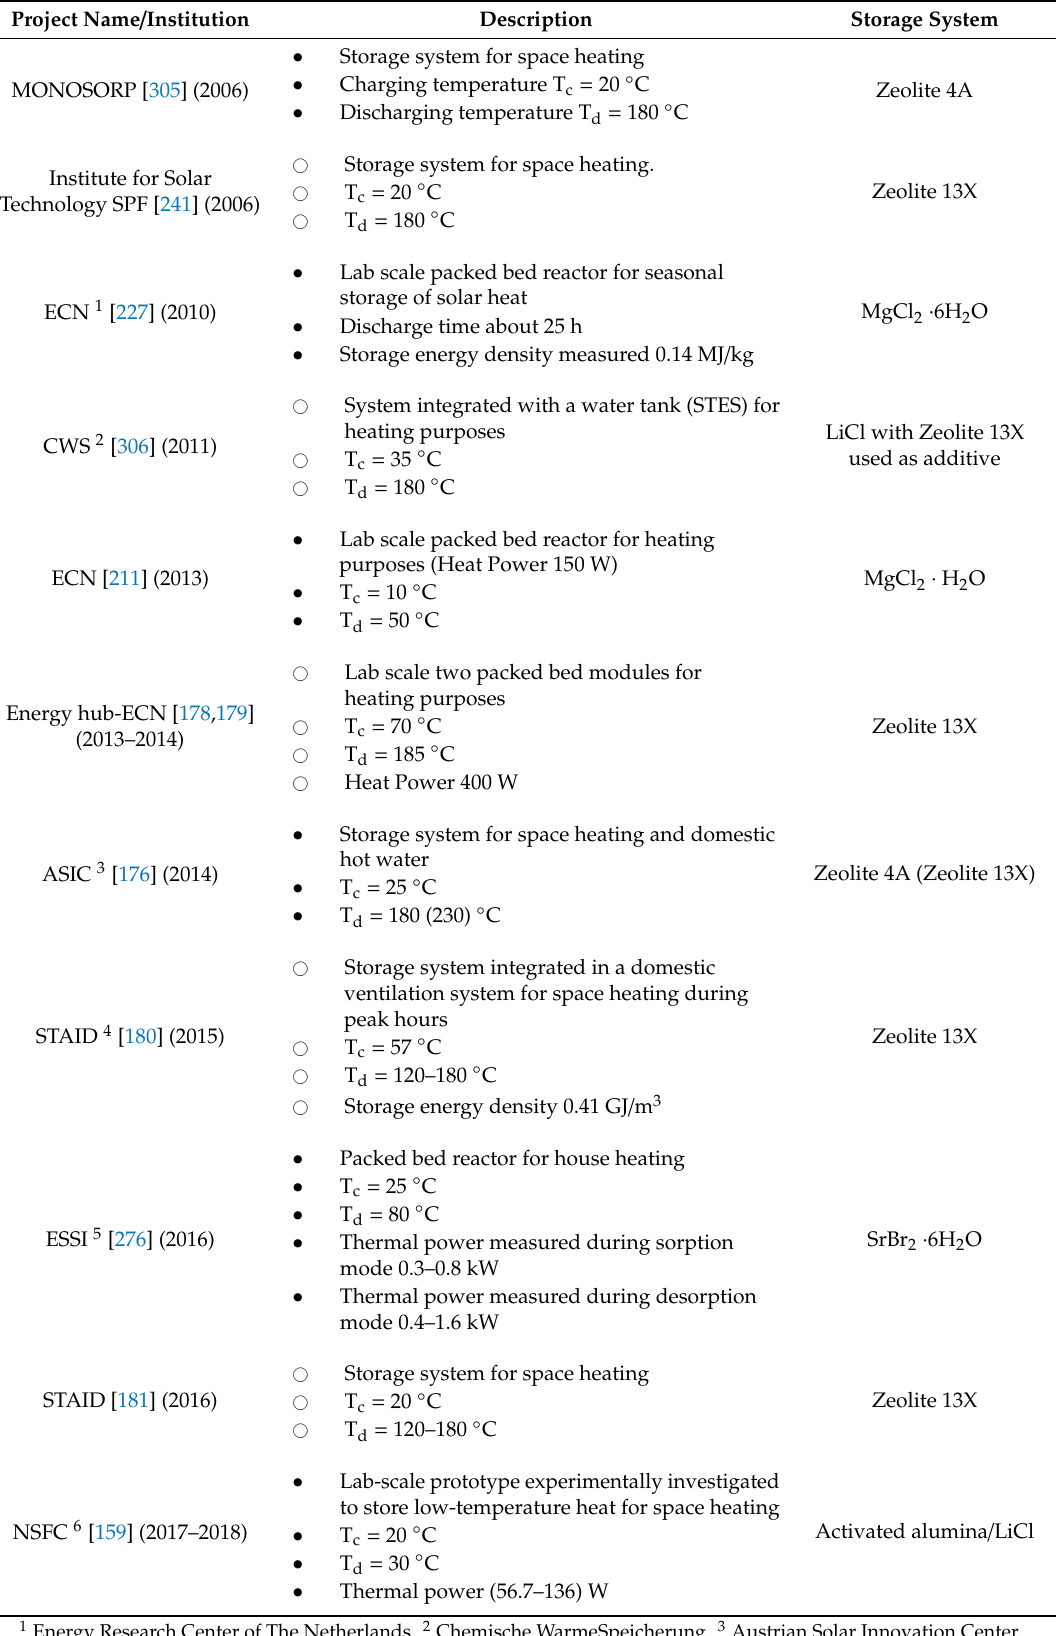
Table 2. Example of prototypes of open systems for thermochemical